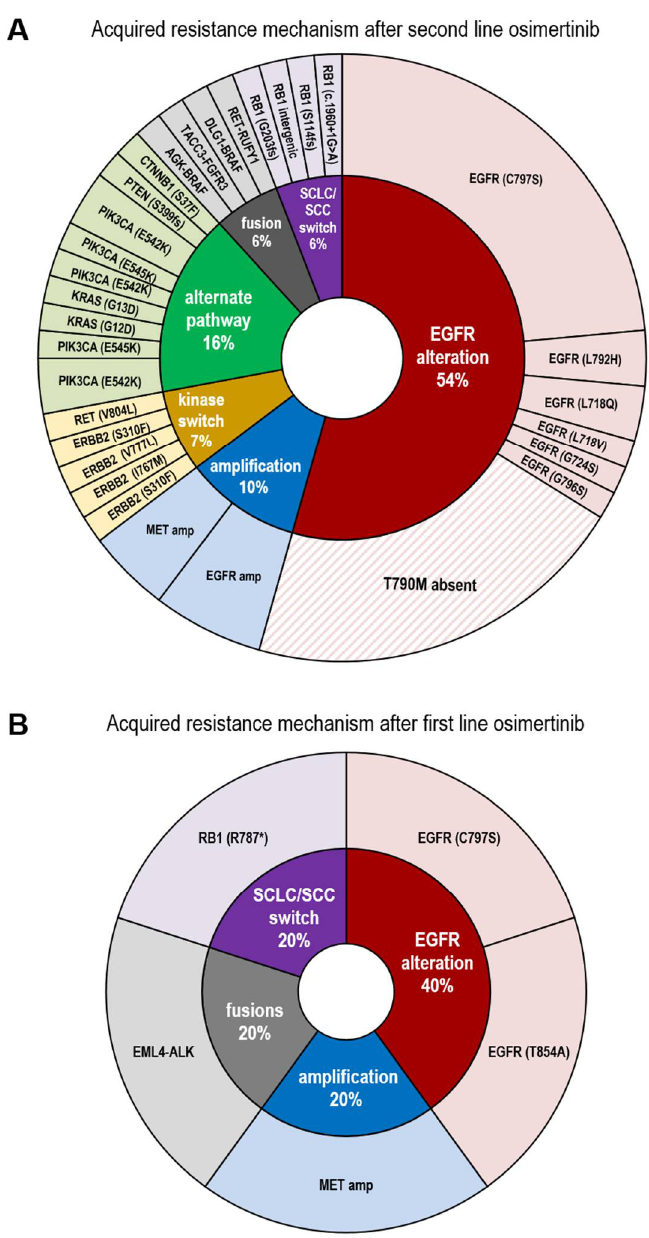
Figure 1. Spectrum of resistance alterations after osimertinib treatment. (A) Patients treated se- quentially with first or/and second generation TKI followed by osimertinib. CtDNA analysis was performed at time of progression to second line osimertinib. Overall 68 resistance mutations were allocated to 41 patients’ samples. Acquired EGFR alterations ( N = 37, 54%) are colored in red, ac- quired amplifications ( N = 7, 10%) in blue, alterations associated with kinase switch in yellow ( N = 5, 7%), resistance mutations indicative for alternate pathway in green ( N = 11, 16%), acquired gene fusions in grey ( N = 4, 6%) and transformation into squamous-cell carcinoma / small cell lung cancer (SCC/SCLC) in purple ( N = 4, 6%). ( B ) Resistance alterations after first line osimertinib of seven NSCLC patients. Two (40%) EGFR resistance alterations (red), one (20%) MET amplification (blue), one EML4-ALK fusion (grey), One RB1 mutation indicative for SCC/SCLC switch (purple) respectively. Patients were excluded from analysis in case the initial EGFR driver mutation was not detectable in plasma